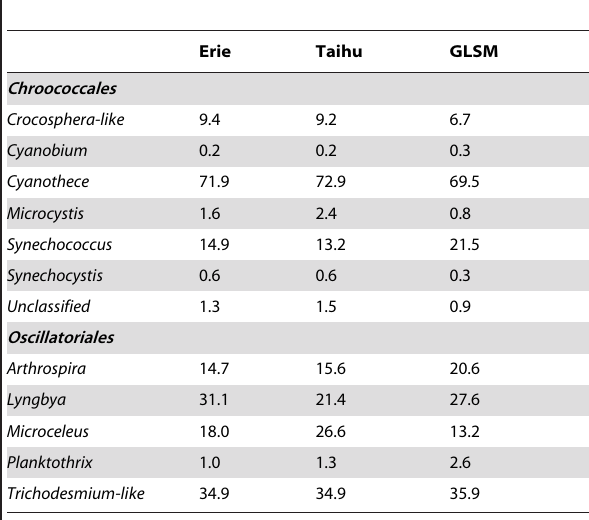
Table 2. Percentage abundance of hits assigned to genera in the orders Chroococcales and Oscillatoriales